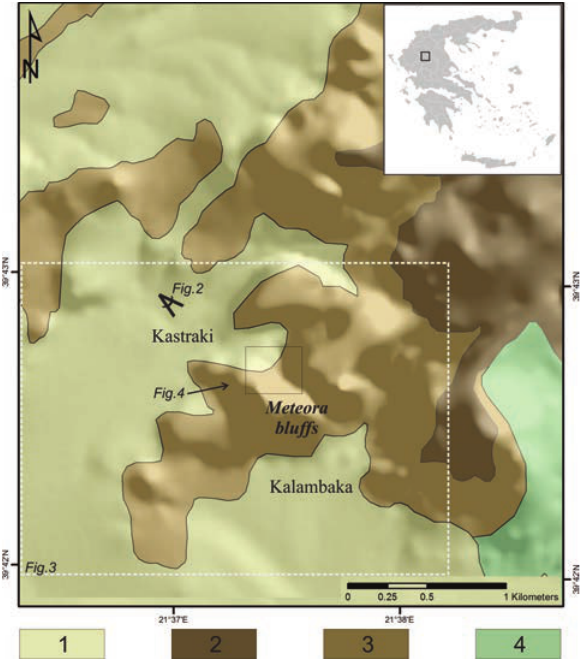
Figure 1. A simplified geological map of the surrounding area (marked at the inset map of Greece) draped on a shaded relief show- ing the impressive contrast of the topography is displayed, with the molassic conglomeratic formations of Tsotili (2), Pentalofos (3) and Eptachori (4) cropping out and surrounded by Quaternary deposits (1). The location of the study area (continuous line, see Figure 4), the direction of the photograph at Figure 2 as well as the extent of Figure 3 (with the dashed line) are also